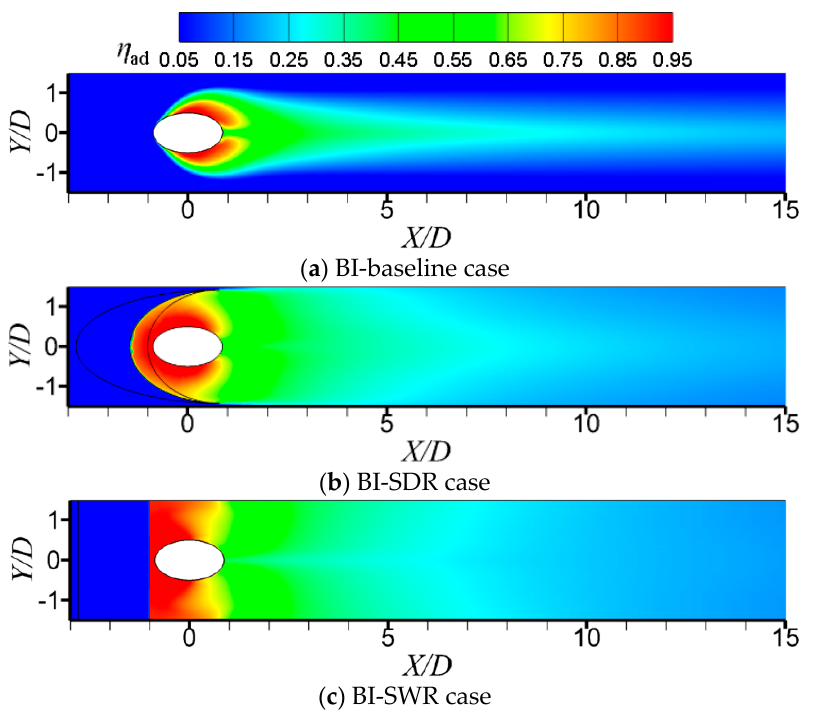
Figure 12. Adiabatic film cooling effectiveness distributions in BI cases under M = 0.5.